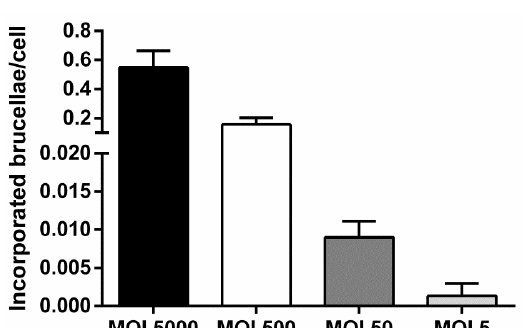
Figure 3. Comparative analysis of incorporated brucellae per cell in ovine macrophages infected with Brucella at various MOIs, 2 days post-infection (results from colony-forming unit (CFU) assay from 500 infected macrophages seeded in blood agar dishes). Each MOI condition was repeated 6 times (six different experiments on macrophages of 6 different sheep). Data are represented as means ± standard deviation. MOI: multiplicity of infection.